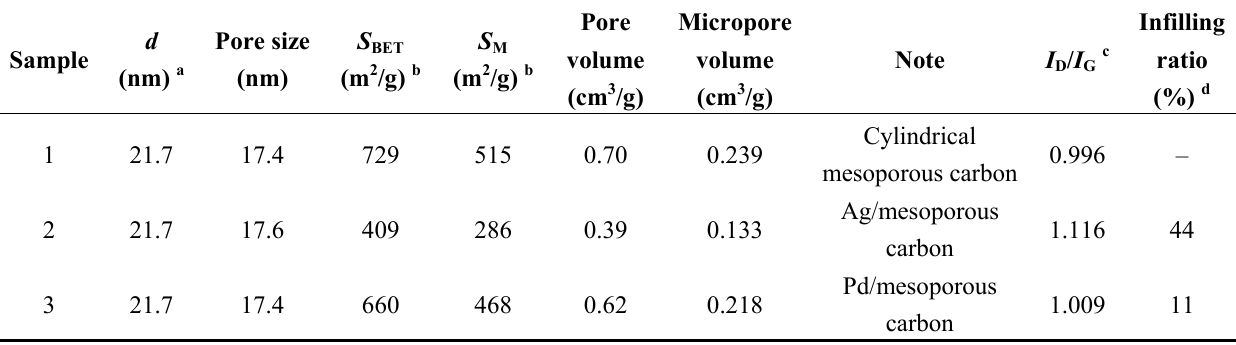
Table 1. Textural properties of the mesoporous carbon and metal/mesoporous carbon